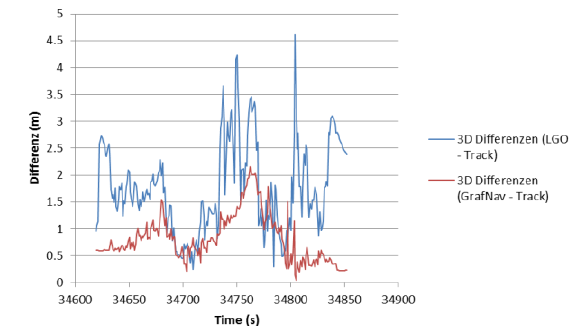
Figure 7. 3D differences between the results of the differential GPS processing and the reference data (tracking data). Figure 5. Footprints of the Falcon trajectories from LGO GPS post-processing, GrafNav GPS post-processing and tracking data (total station).